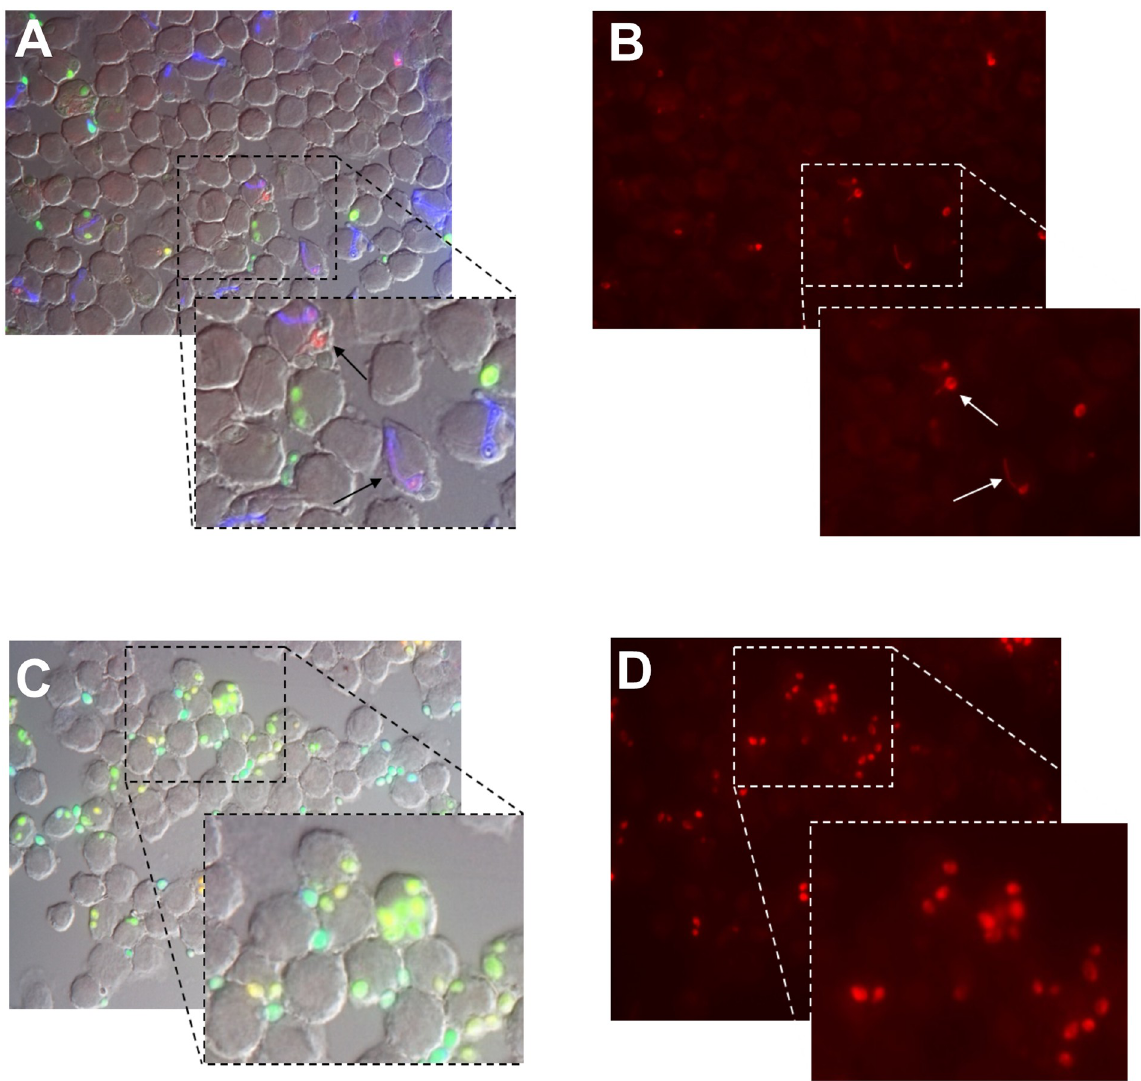
Fig 4. Morphology of C . albicans treated with the different MoWs and then exposed to phagocytic cells. Representative fluorescent microscopy images of yeast cells, treated for 5 or 15 minutes with MoWs or PBS, as a control, washed, suspended in cRPMI, fluorescently labelled and seeded (2 x 10 5 cells/well) in chamber-slides containing BV2 phagocytic cells (1 x 10 5 cells/well; E:T ratio = 1:2). After 1.5 hours incubation at 37˚C, slides were fixed and fluorescent signal was acquired. C . albicans cells treated with PBS, MoW 1 or MoW 4 retain their ability to undergo dimorphic transition, even when phagocytized by macrophages (representative image in panel A of MoW 4 –black arrows), therefore, only little numbers of red spots (representative image in panel B of MoW 4—white arrows) are visible. C . albicans cells treated with MoWs 2, 3, 5 and 7, are inhibited in their capacity to undergo dimorphic transition and they retain their yeast morphology (representative image in panel C of MoW 2), therefore most of them are localized inside acidic phagolysosomes (representative image in panel D of MoW 2) where they are likely inactivated. The different colours displayed by fungal cells in panels A and C indicate the fungi simply phagocytized (green Candida , stained with FITC), the fungi phagocytized and associated with acidic phagolysosomes (red Candida , stained with the acidotropic LysoTracker DND-99 dye), or the fungi not phagocytized by BV2 cells (blue Candida , stained with Uvitex 2B). Panels B and D show the same images of panels A and C respectively, using the TRITC filter, which highlights only the Candida cells (stained in red with LysoTracker DND-99 dye) localized within the acidic phagolysosomes. Every condition was assessed in at least 3 different experiments. MoW1: Curasept 0.20; MoW2: Dentosan Collutorio; MoW3: Meridol Collutorio; MoW4: Elmex Sensitive Professional; MoW5: Listerine Total Care Zero; MoW7: Parodontax.